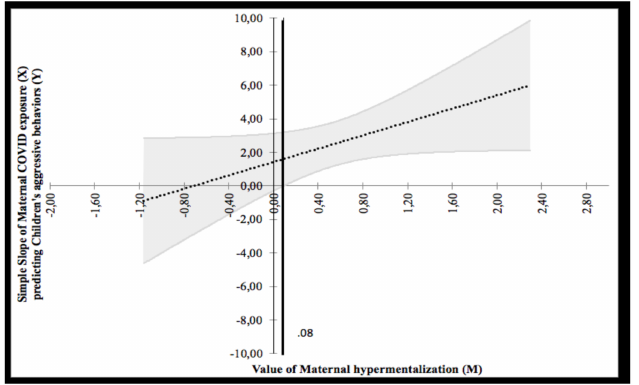
Figure 7. Probing interaction with the Johnson–Neyman Technique for the COVID-19 Exposure Predictor and the maternal hypermentalization moderator on children’s aggressive